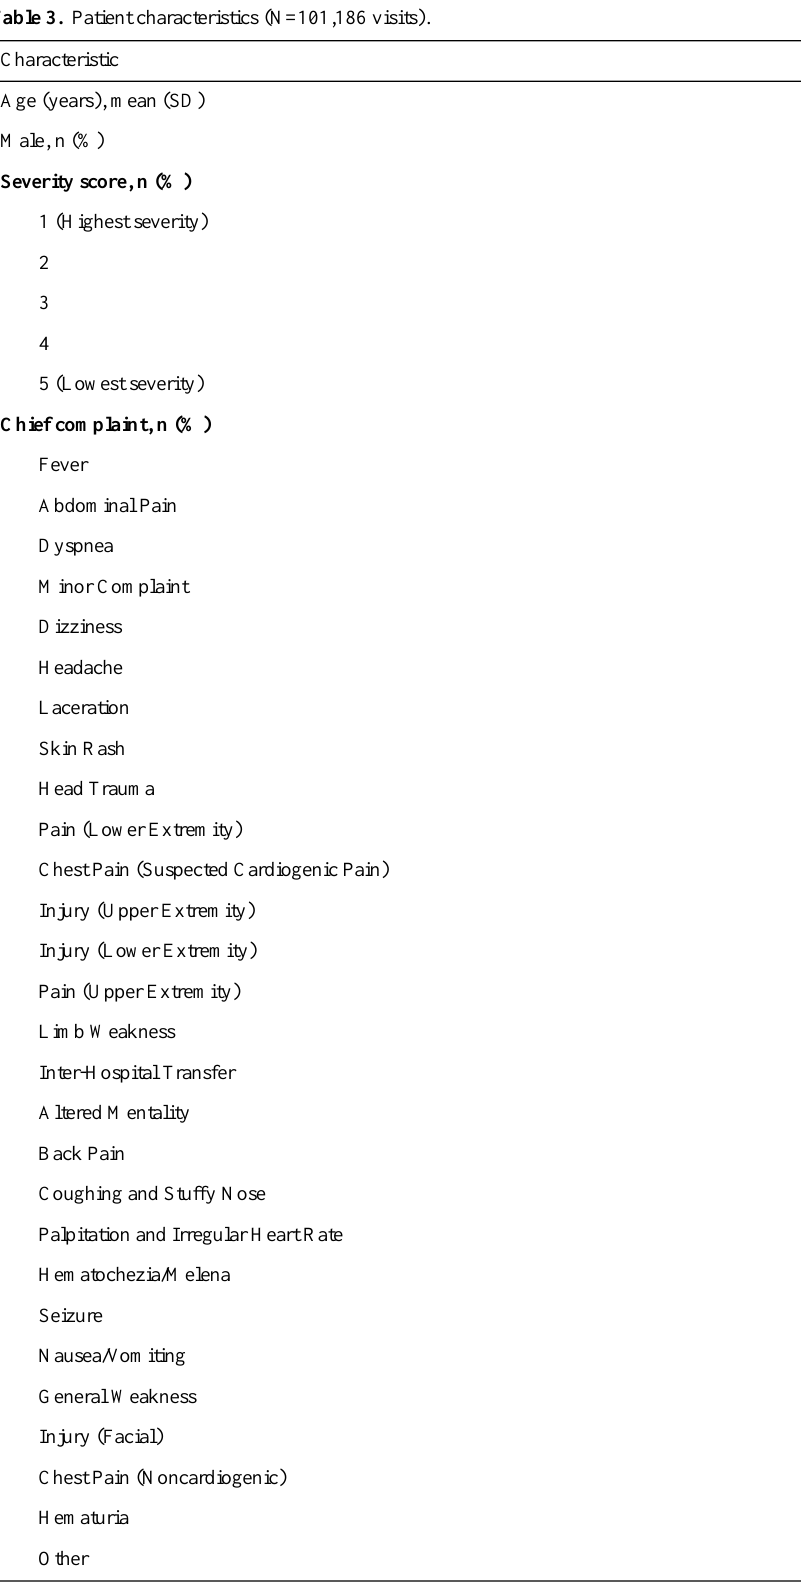
Table 3. Patient characteristics (N=101,186